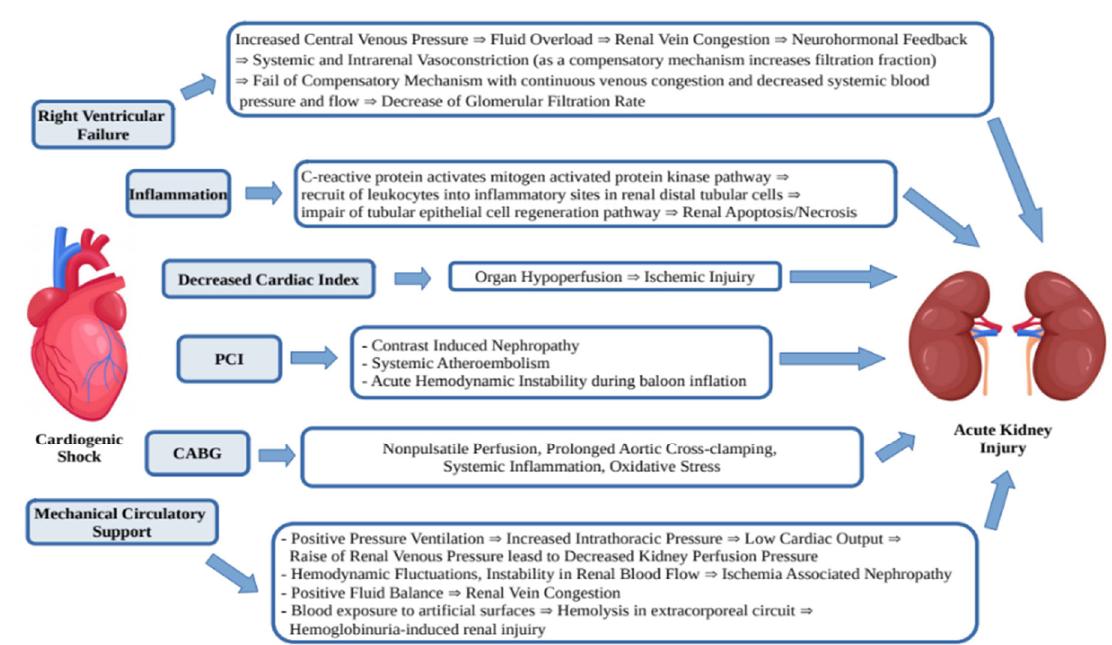
Figure 1. Mechanisms of acute kidney injury in CS ‐ AMI.